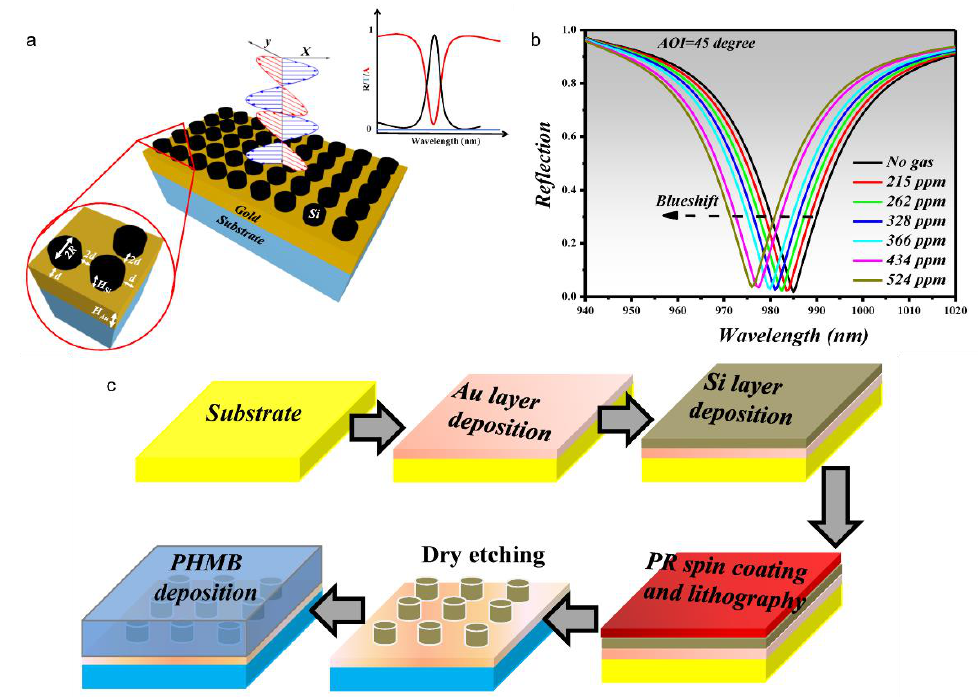
Figure 7. ( a ) A thin layer of PHMB functional layer was deposited on the perfect absorber metasur- face. CO 2 gas was detected via the wavelength interrogation method. ( b ) Reflection spectra for dif- ferent gas concentrations in the ppm range. ( c ) Proposed fabrication scheme [97] Copyright: © 2021 MDPI.